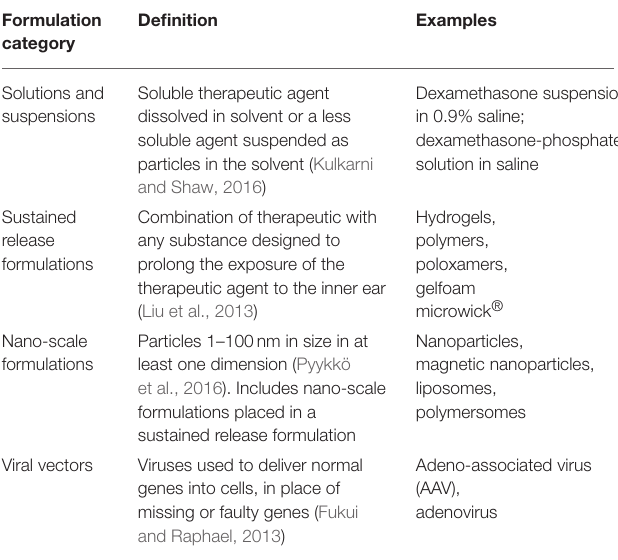
TABLE 3 | Categorization of formulations used in therapeutic delivery to the inner ear with definitions and